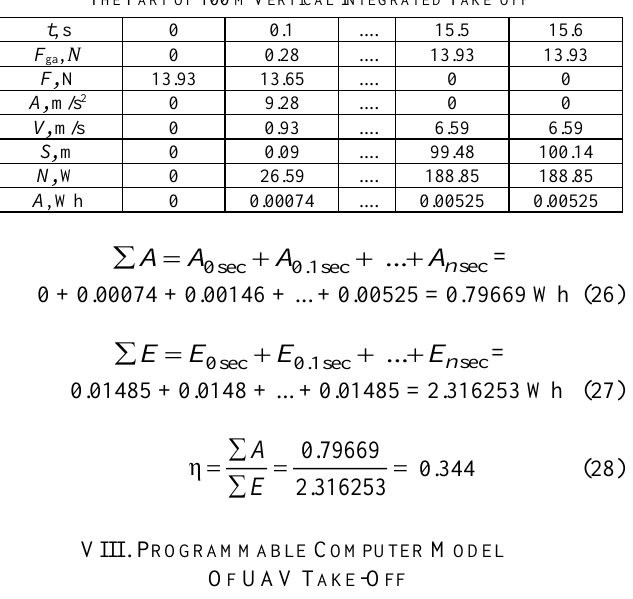
The part of quadcopter computer model code is presented in Fig. 8. The part describes the computer and optimisation controller interaction to assess the ability of the microcontroller TABLE I to perform the optimal control. M EASUREMENTS AND C ALCULATIONS OF BR2216 KV810 M OTOR The microcontroller ATMEL328P is equipped with an for searching for optimal power